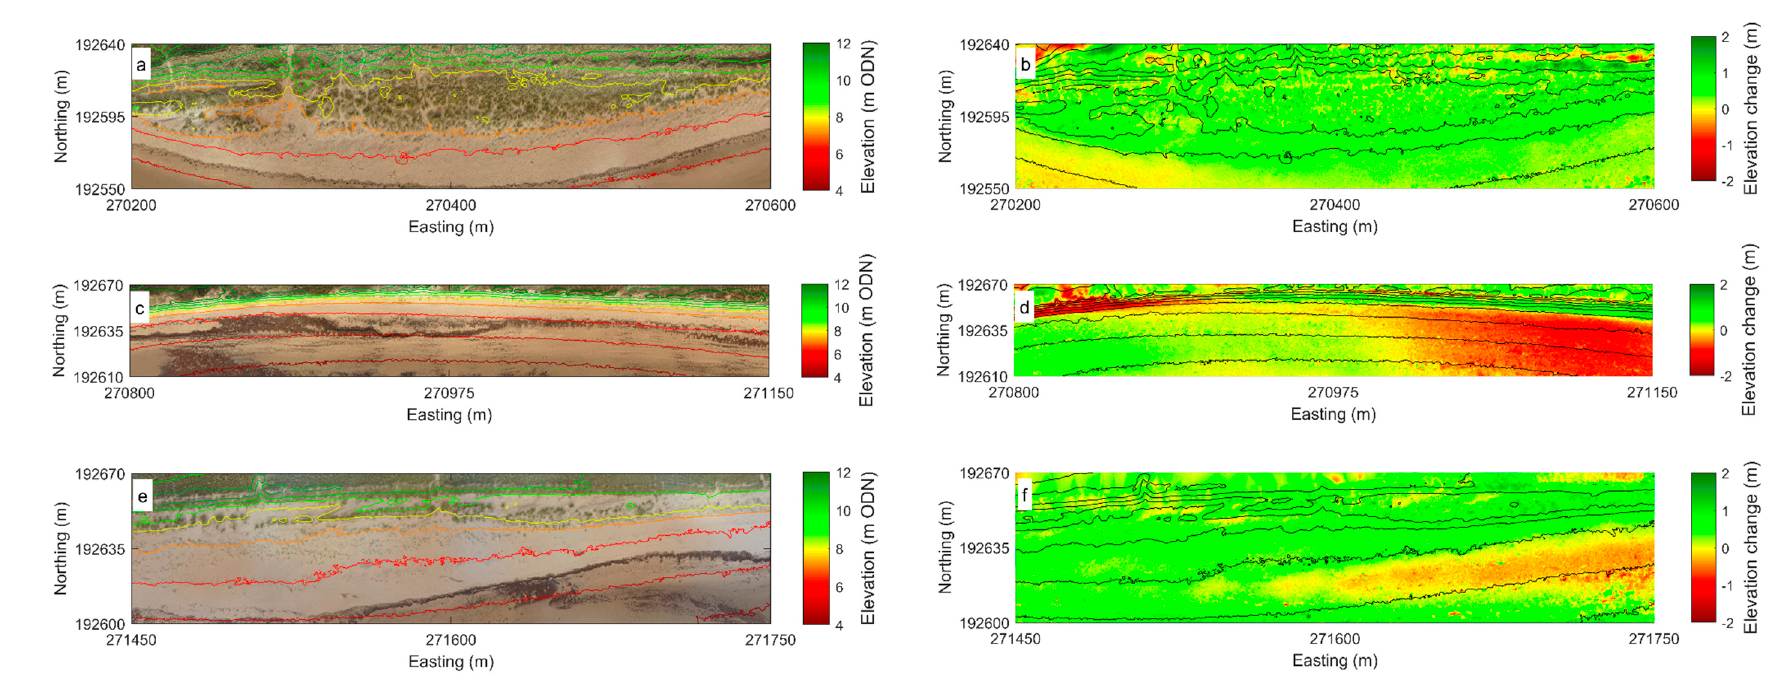
Figure 8. ( a ) An orthomosaic of the first dune section (Area 1) with colored elevation contours at 1 m intervals; ( b ) change in elevation between first and last survey Figure 1. the same contours as ( a ) are displayed in black; ( c , d ) the same plots for Area 2; ( e , f ) the same plots for Area 3.